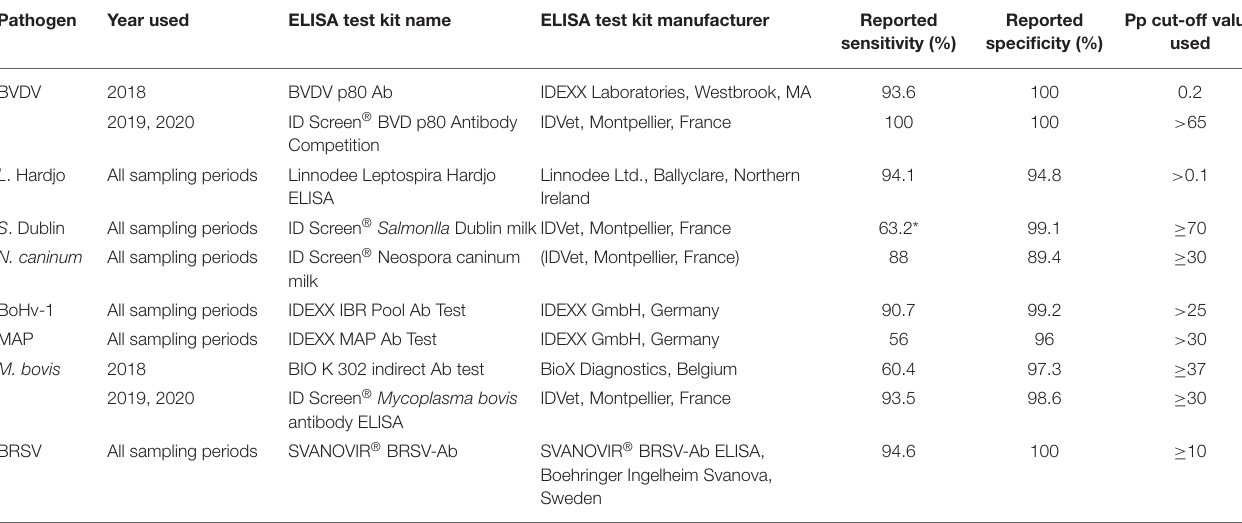
TABLE 1 | Details of ELISA kits used to test bulk tank milk samples from study herds between 2018 and 2020.